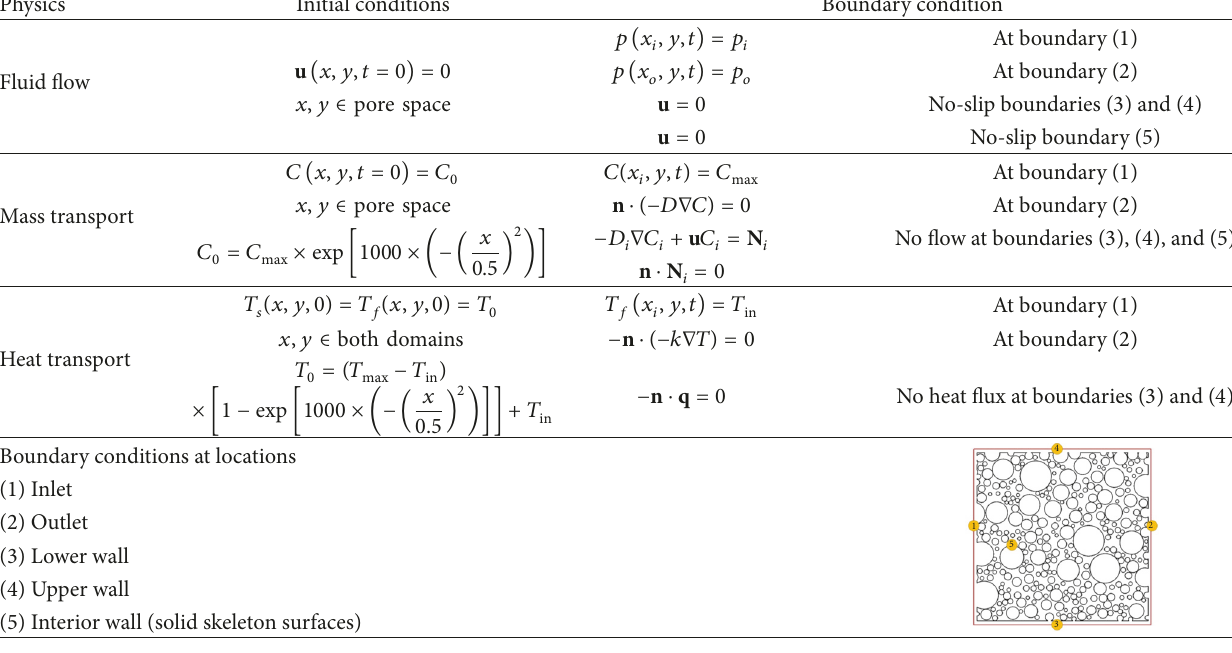
Table 4: The initial and boundary conditions for the fluid flow, mass, and heat transport. Physics